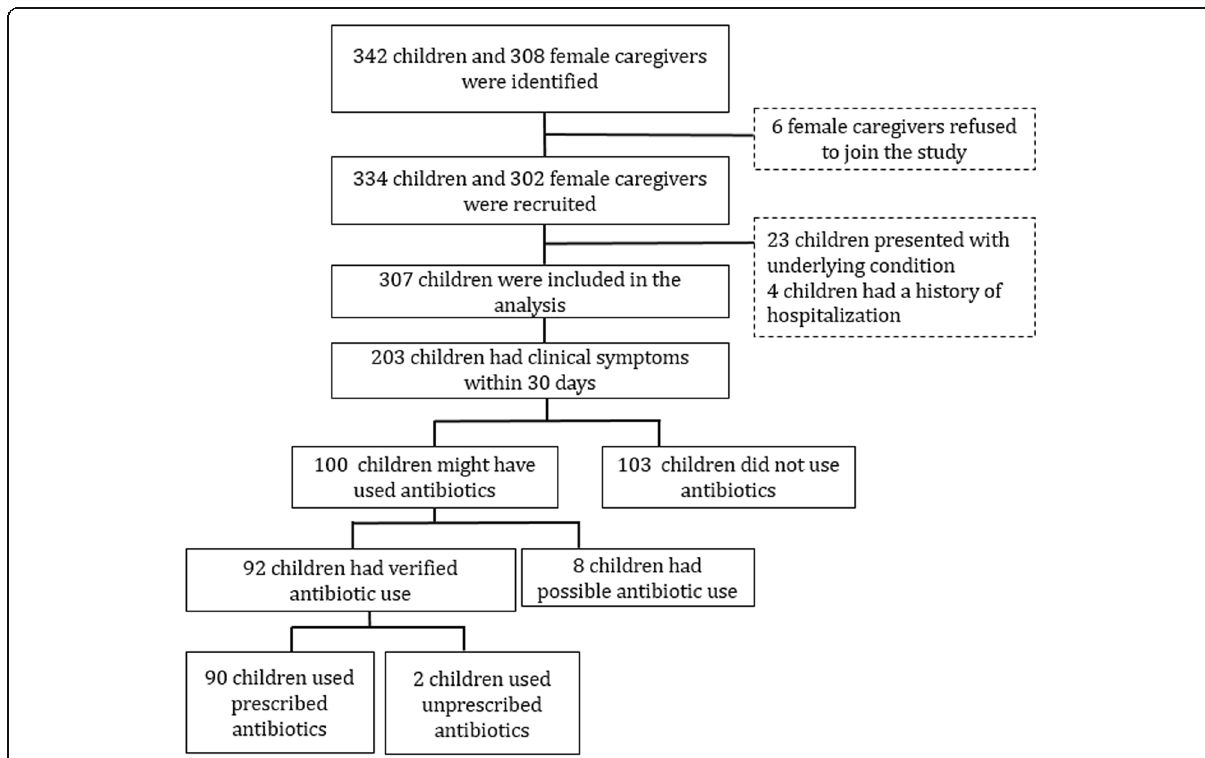
Fig. 1 Flowchart of the recruitment of study